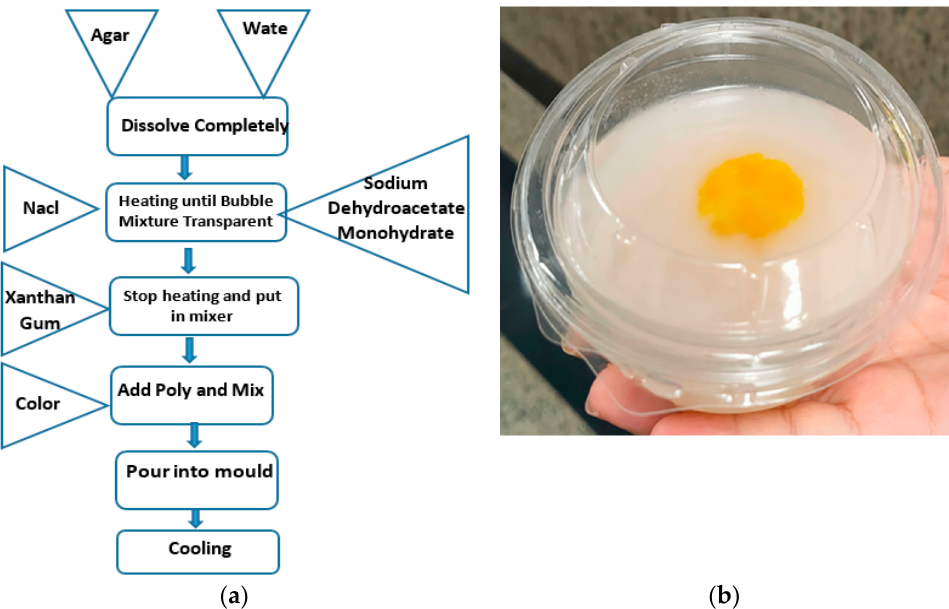
Figure 3. Breast and tumor models fabrication: ( a ) fabrication flow chart and ( b ) breast model with tumor cells in the middle.